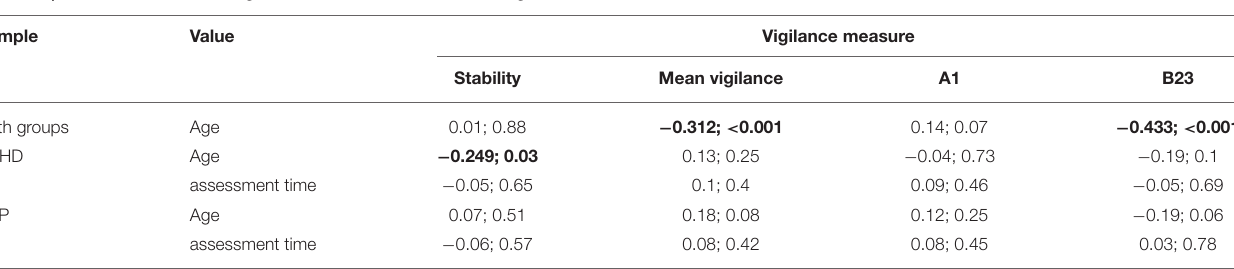
TABLE 6 | Correlation statistics of age and assessment time and EEG